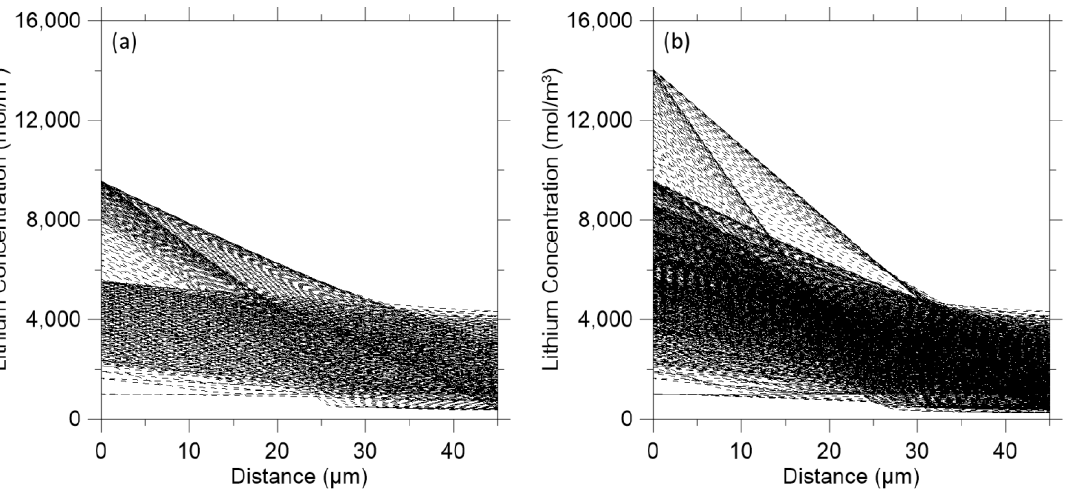
Figure 7. Distribution of lithium concentration on both electrodes: ( a ) Without the polymer composite layer on the anode; ( b ) With the polymer composite layer on the anode.